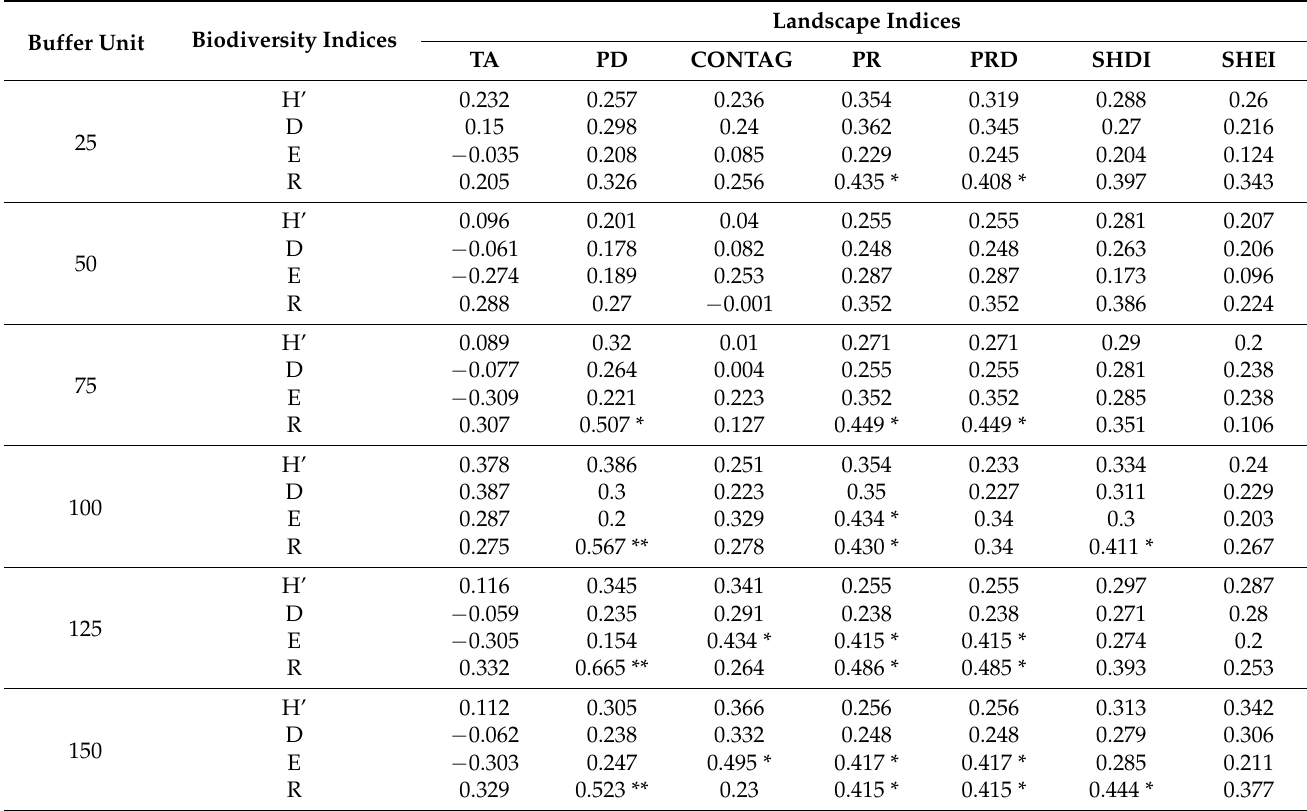
Table 5. Correlation coefficients between landscape indices of different buffer radius and species diversity